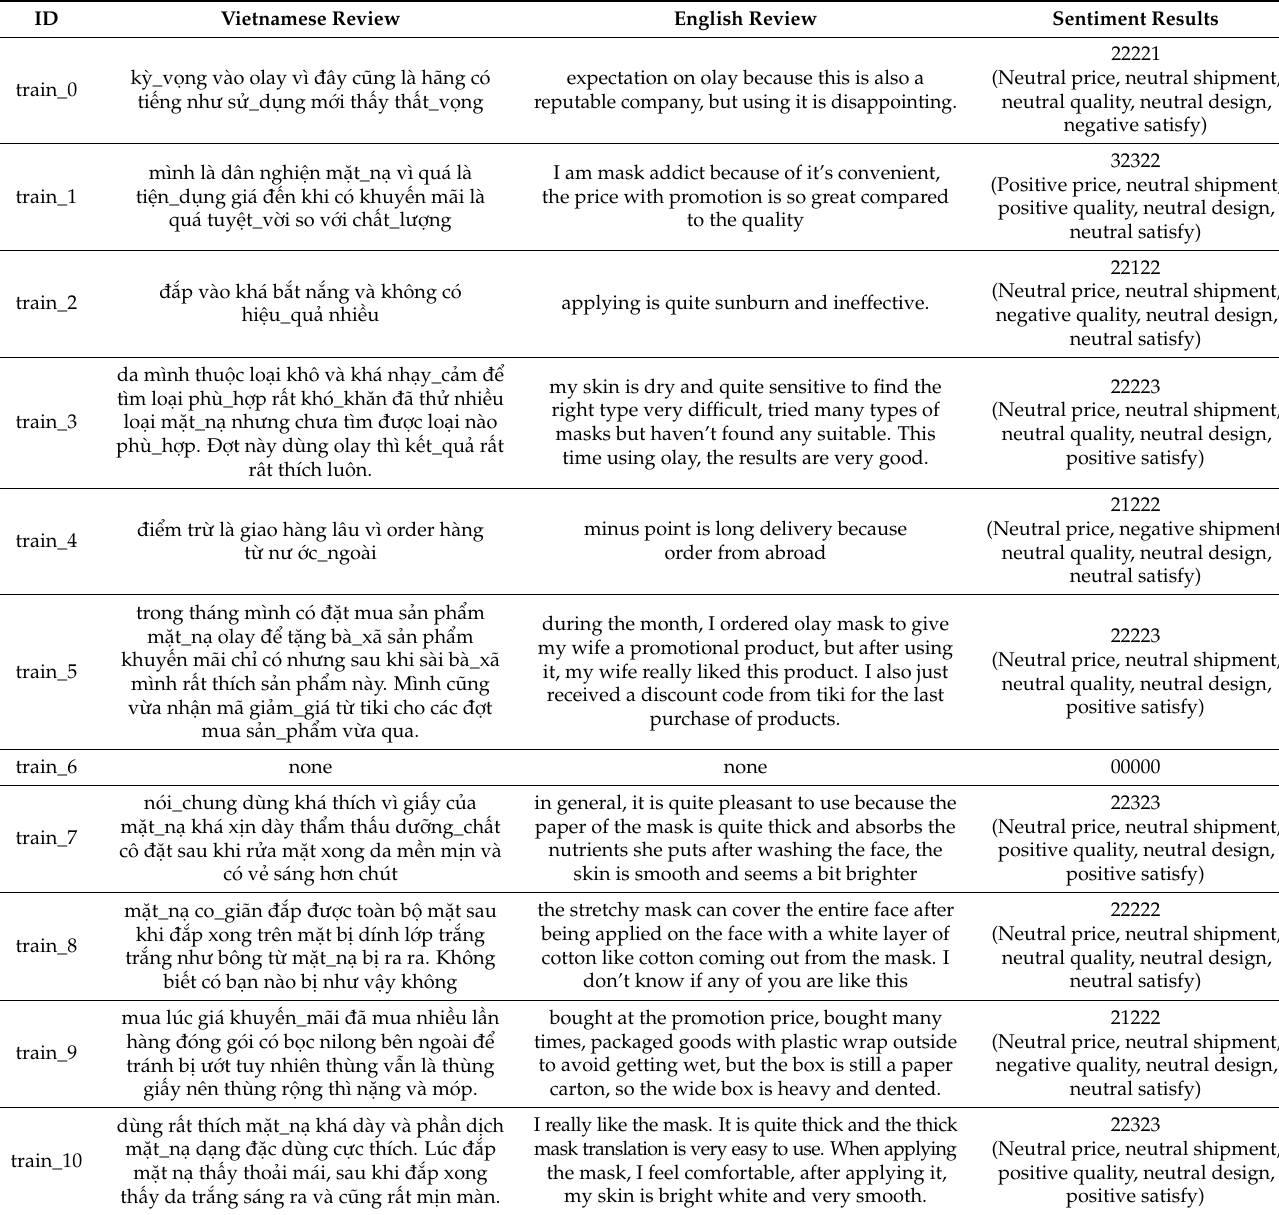
Table 3. Data training